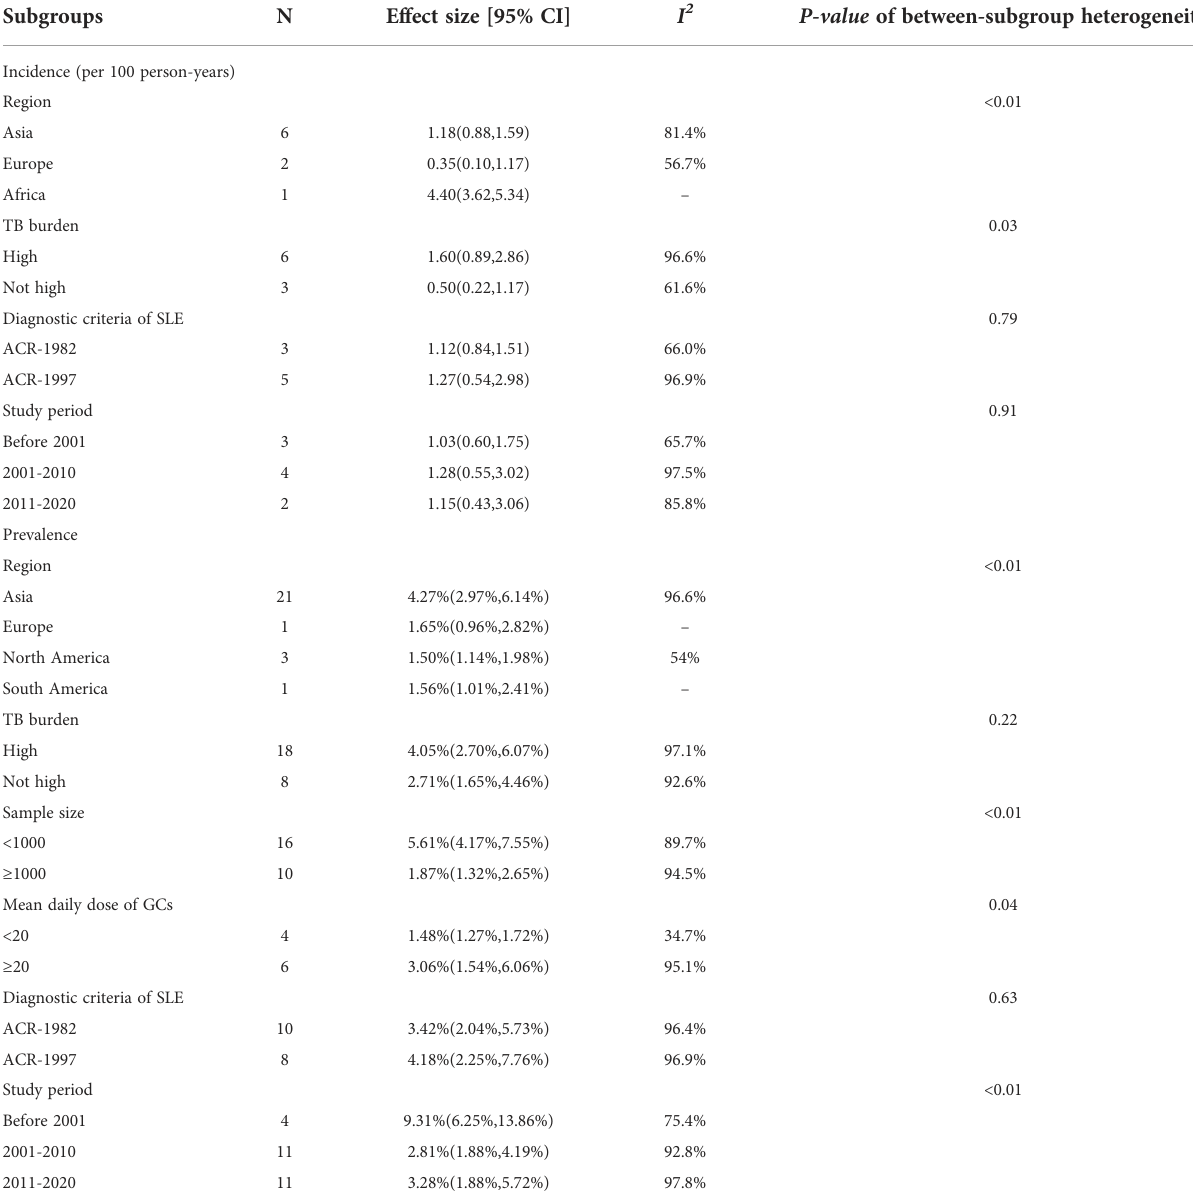
TABLE 3 Subgroup analysis of TB incidence and prevalence among SLE patients. Subgroups N Effect size [95% CI] I 2 P-value of between-subgroup